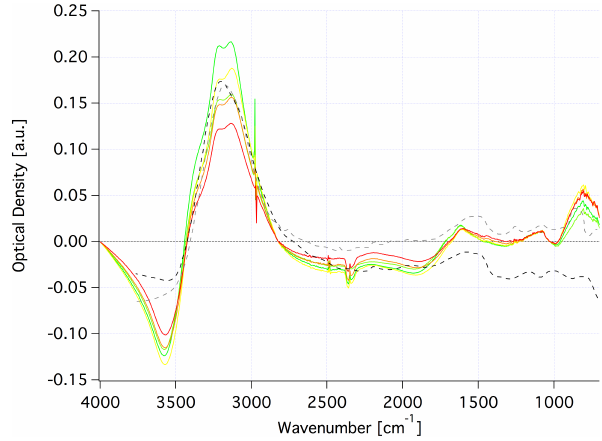
Figure 11: Evolution of amHCl film. The spectrum of a pure ice film is represented in 1259 Figure 11. Evolution of amHCl film: the spectrum of a pure ice film is represented in black, and the conversion of an amHCl from black and the conversion of an amHCl from a H 2 O-rich film (purple spectrum) to an 1260 a H 2 O-rich film (purple spectrum) to an amorphous HCl–ice film amorphous HCl/ice film (red spectrum) while pumping under SFR are displayed in 1261 (red spectrum) while pumping under SFR is displayed in colour. colour. The spectra are colour-coded as a function of temperature in the range 175 to 1262 The spectra are colour-coded as a function of temperature in the 200 K, with each spectrum corresponding to a temperature increase of roughly 3 K. 1263 range 175 to 200K, with each spectrum corresponding to a tem- All spectra from blue to red have been measured in the aftermath of the first pulse in a 1264 perature increase of roughly 3K. All spectra from blue to red have series of consecutive PV experiments. A constant flow of HCl has been used in going 1265 been measured in the aftermath of the first pulse in a series of con- from black (pure ice) to purple. 1266 secutive PV experiments. A constant flow of HCl has been used in going from black (pure ice) to purple.